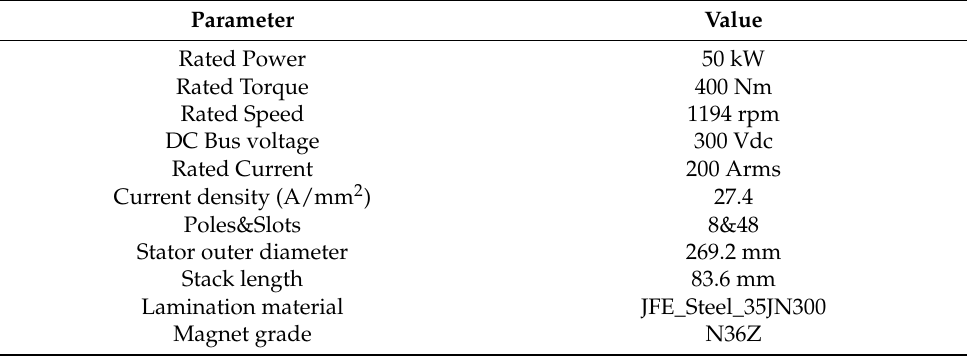
Table 1. Design specifications of used